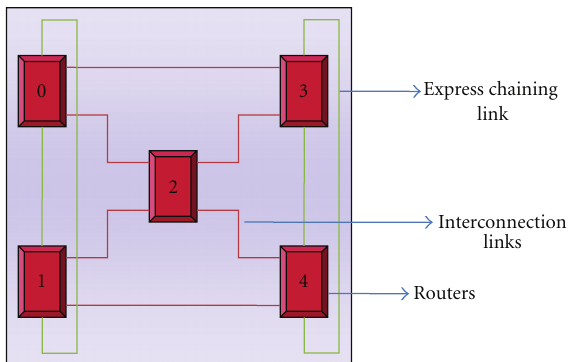
Figure 5: Following are the legends used in the simulation